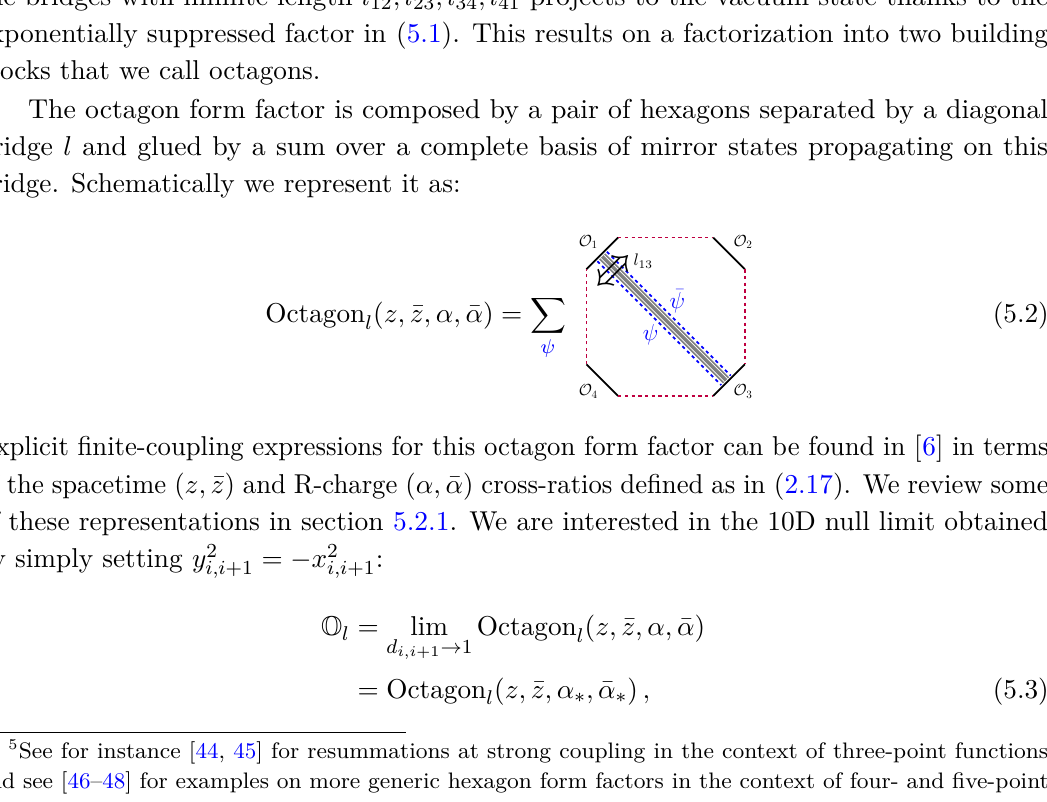
, tessellated into four hexagons ij } that propagate ij } give the sum G of all ij